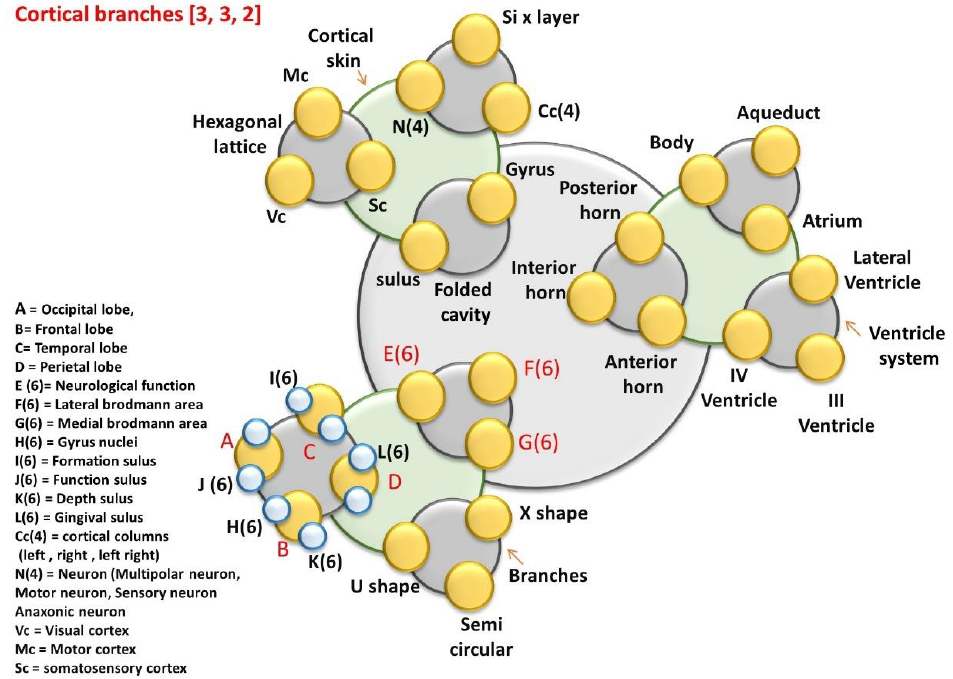
Figure 7. 2D clock architecture or time crystal representation of the cortical branch network of the brain [41].